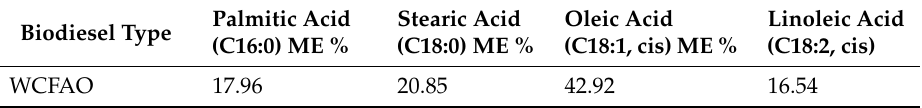
Table 4. The fatty acid methyl ester (ME) composition of the synthesized biodiesel.